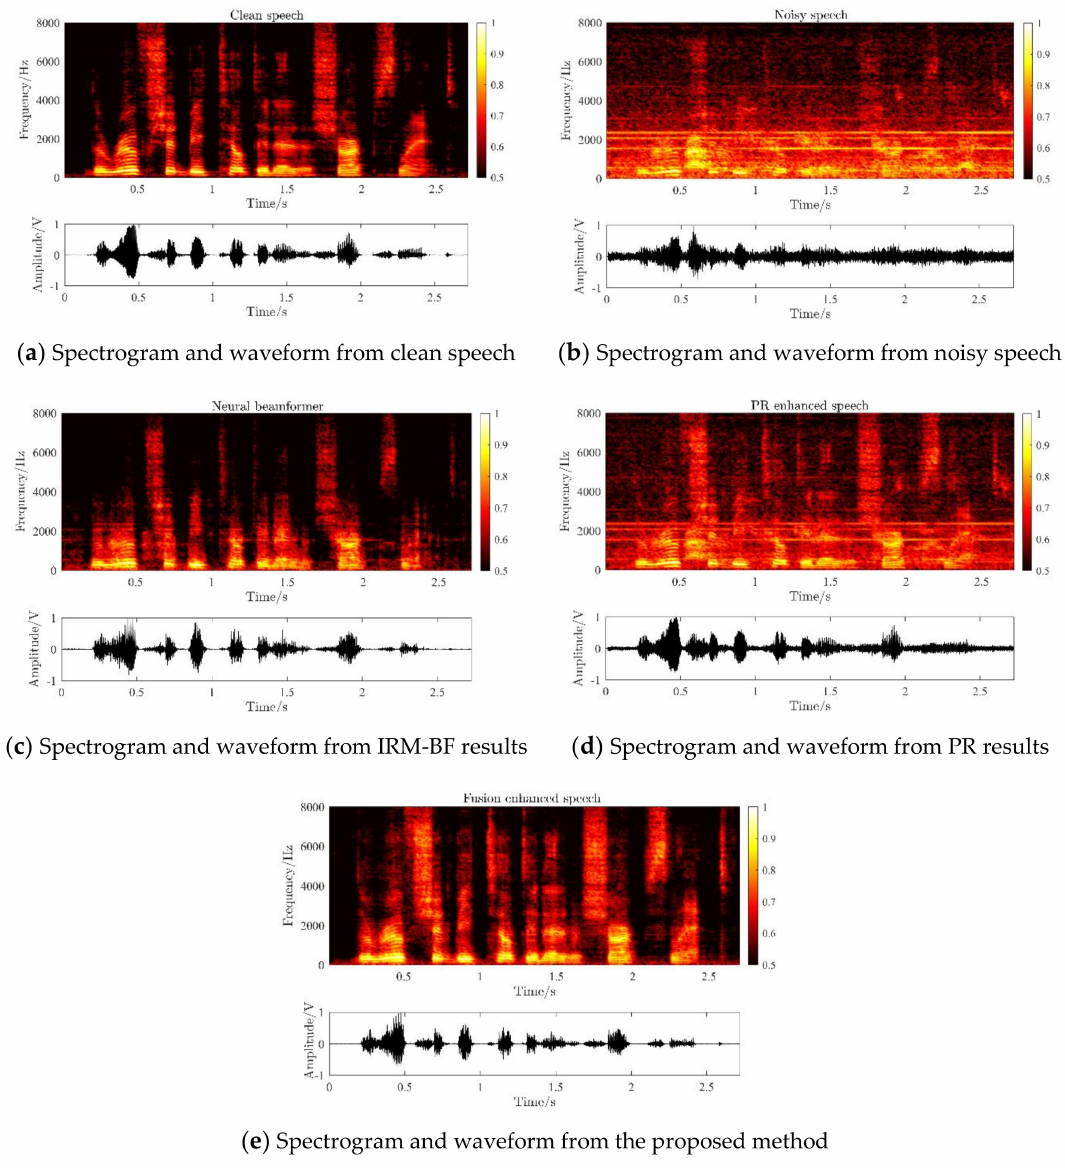
Figure 6. ( a – d ) are the spectrograms and waveforms from clean speech, noisy speech, PR model, and multi-channel beamforming preprocessing, respectively. The spectrogram of our final output is listed in ( e ). ( a ) Spectrogram and waveform from clean speech; ( b ) Spectrogram and waveform from noisy speech; ( c ) Spectrogram and waveform from IRM-BF results; ( d ) Spectrogram and waveform from PR results; ( e ) Spectrogram and waveform from the proposed